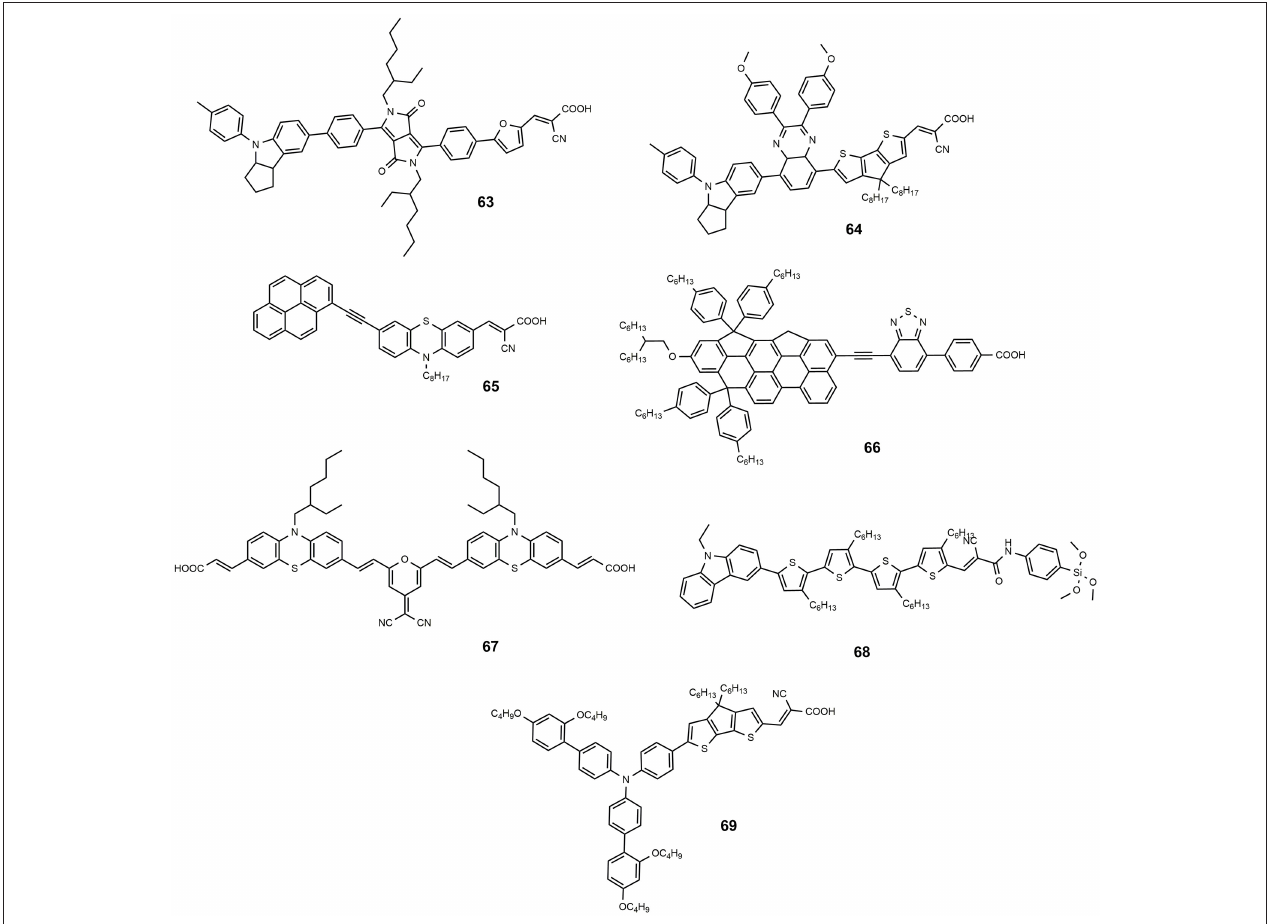
FIGURE 9 | Chemical structures of dyes